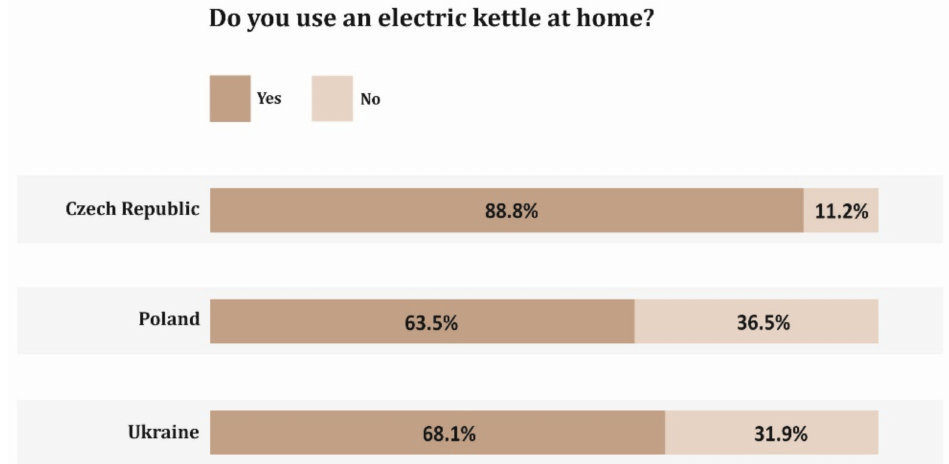
Figure 6. Distribution of answers to the question on the use of the electric kettle by the surveyed students. Source: own study.